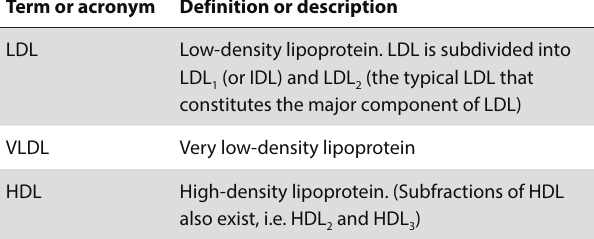
Table 2: Important terminology pertaining to the density of commonly occurring lipoprotein complexes 9,10 Term or acronym Definition or description